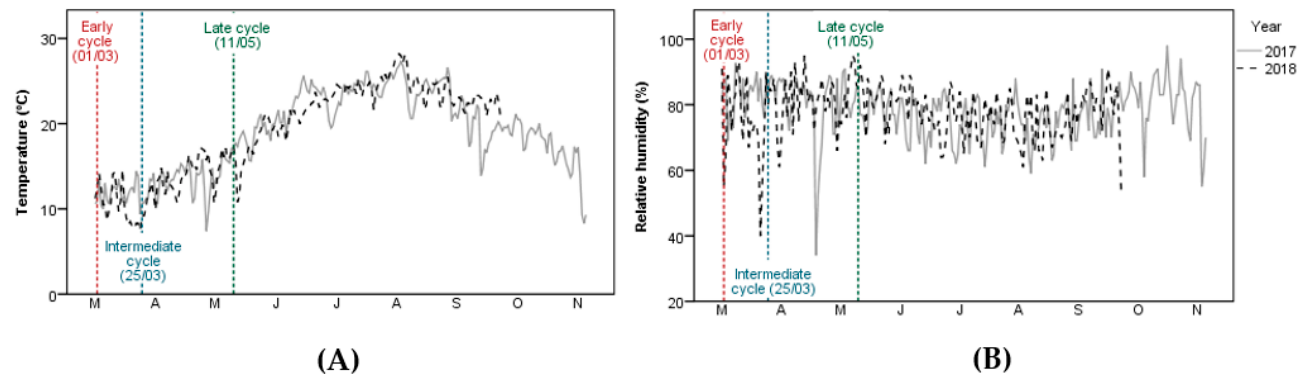
Figure 1. Climatic conditions recorded in the experimental trials: ( A ) temperature, ( B ) relative humidity. Sowing dates for early (in red), intermediate (in blue), and late cycles (in green) are presented inside parentheses. The lengths of the registers for 2017 (continuous line) and 2018 (dashed line) are different because the late cycle was studied only in 2017.